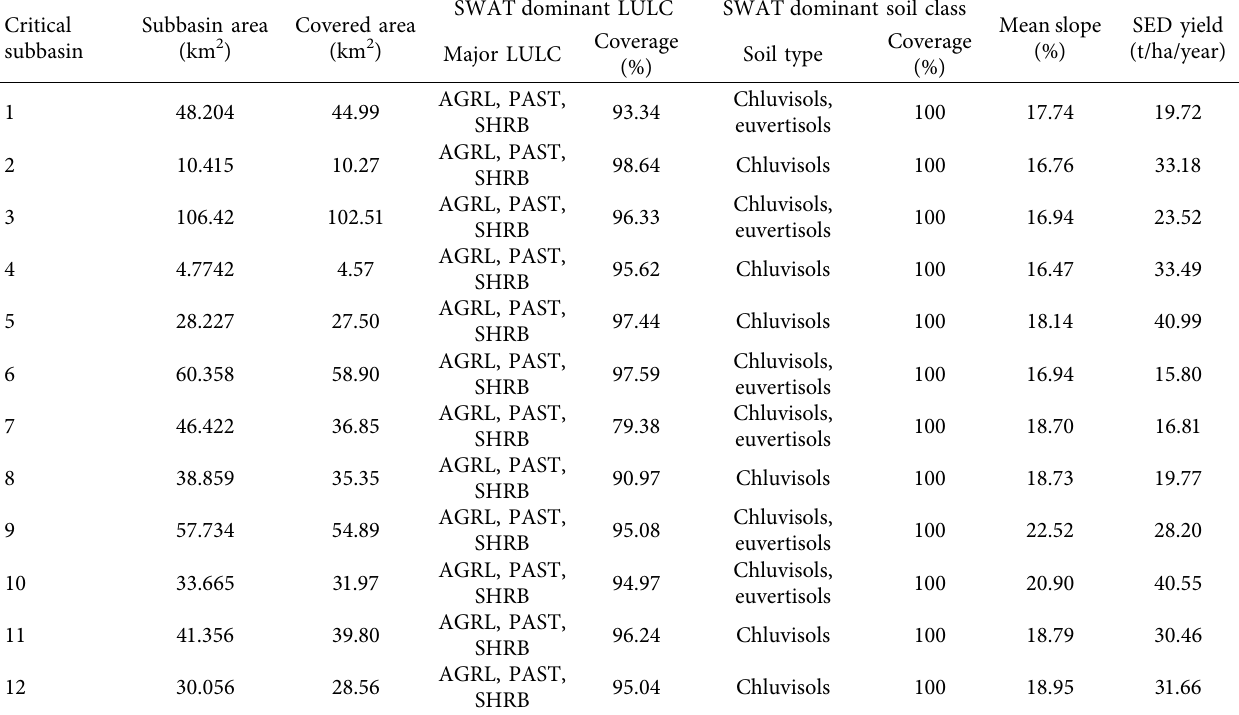
Table 12: Soil erosion prone at subbasins’ level with their dominant LULC, soil type, and average slope. Critical